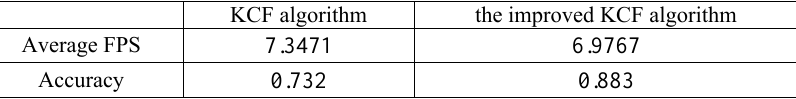
Table 1. Average frame rate and accuracy of KCF and improved KCF